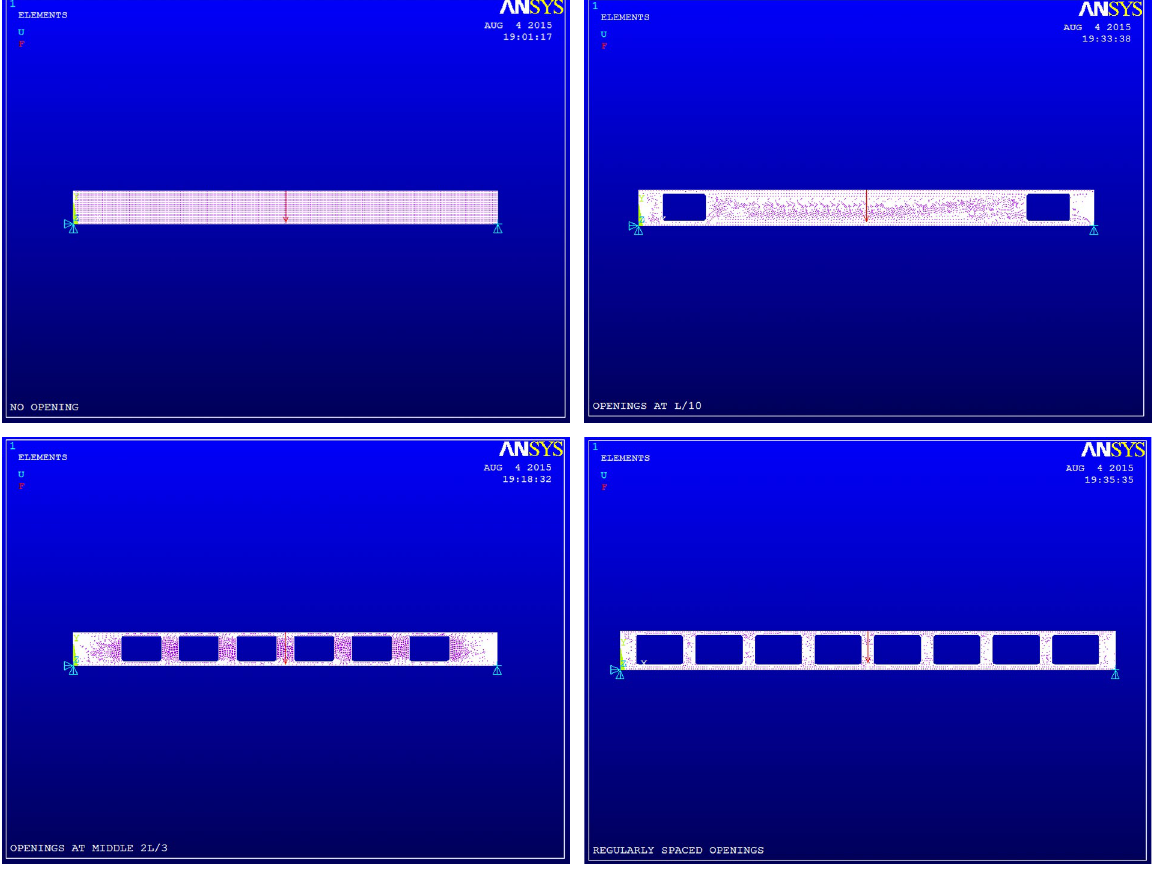
Fig. 19. Position of web openings